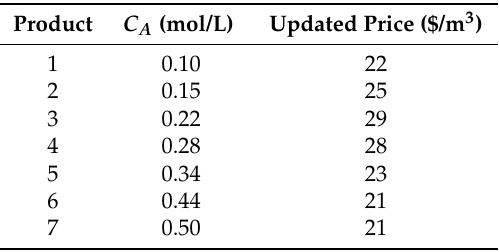
Table 8. Scenario 5: Updated market